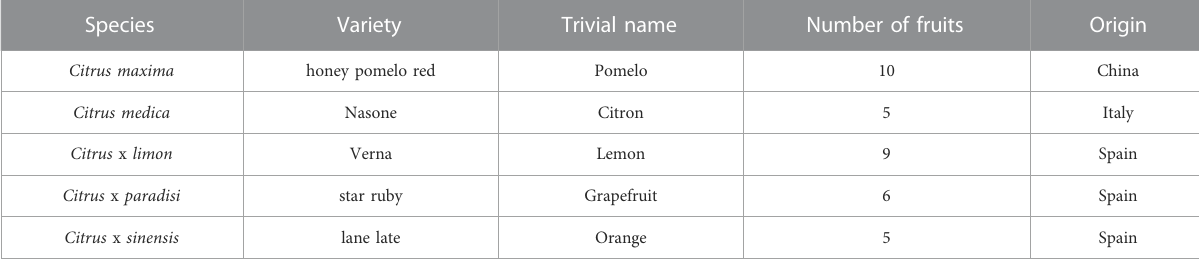
TABLE 1 Overview of species used and varieties of Citrus spp. for quasi-static compression